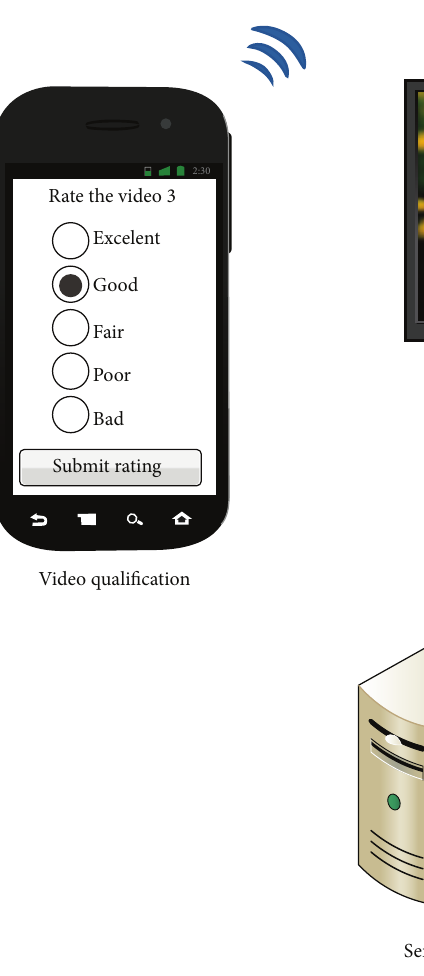
Figure 3: Automatic rating system for subjective tests.